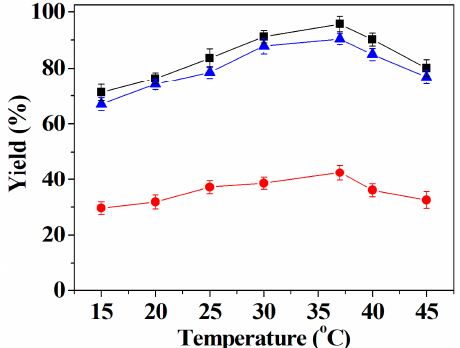
Figure 5. Effect of temperature on the DFF yield of co-immobilized tri-enzymes ( ■ ), separately immobilized tri-enzymes ( ▲ ) and free tri-enzymes ( ● ). Reaction conditions: 35 mg of co-immobilized tri-enzymes or 105 mg of separately immobilized tri-enzymes (containing 35 mg of immobilized galactose oxidase, 35 mg of immobilized catalase and 35 mg of immobilized horseradish peroxidase) or free tri-enzymes (20 U of galactose oxidase, 8000 U of catalase and 500 U mg of horseradish peroxidase); 200 mM of HMF; Tris-HCl buffer (50 mM, pH 6.6) for co-immobilized tri-enzymes and separately immobilized tri-enzymes, and Tris-HCl buffer (50 mM, pH 7.1) for free tri-enzymes; at different temperatures ranging from 15 to 45 °C.